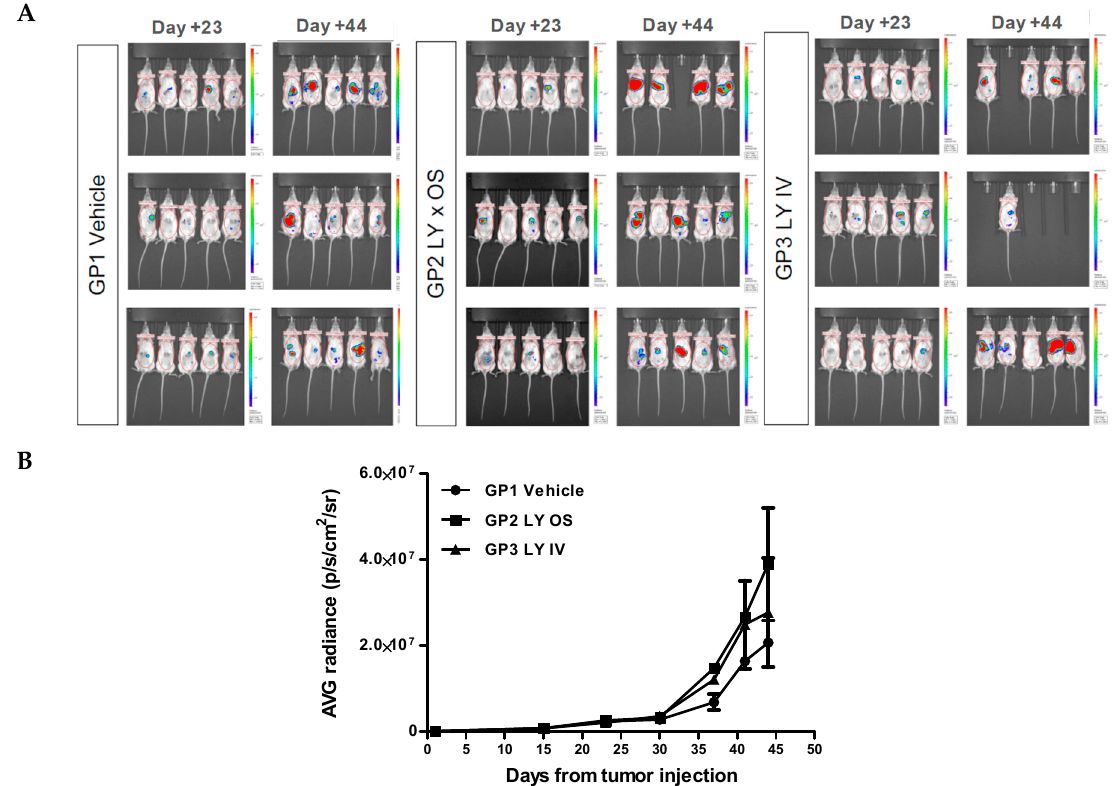
Figure 4. Treatment of NOD/Shi-Scid/IL-2R γ null Common gamma Ray (NOG) mice with luciferin- labeled hepatocellular carcinoma (HCC) with vehicle or two Galunisertib preparations. ( A ). Bioluminescence images of NOG mice prior injected intrahepatically with HepG2-Luc cells at Day 23 and 44 after vehicle injection (GP1), or Galunisertib administration via gavage (GP2) or intravenous route (GP3). ( B ) Average Radiance (IVIS) versus time after tumor inoculation. Data were averaged over the animals which reached the end of experiment (GP1: n = 15; GP2: n = 14; GP3: n = 10). Beginning from Day 30 after cell injection the signal showed a moderate increasing trend indicative for of tumor growth. Small differences can be seen between the treatment groups but no significant difference in bioluminescence was observed. During the treatment period (Day 16–Day 44) no effect on tumor regression or prevention of metastasis was noted.